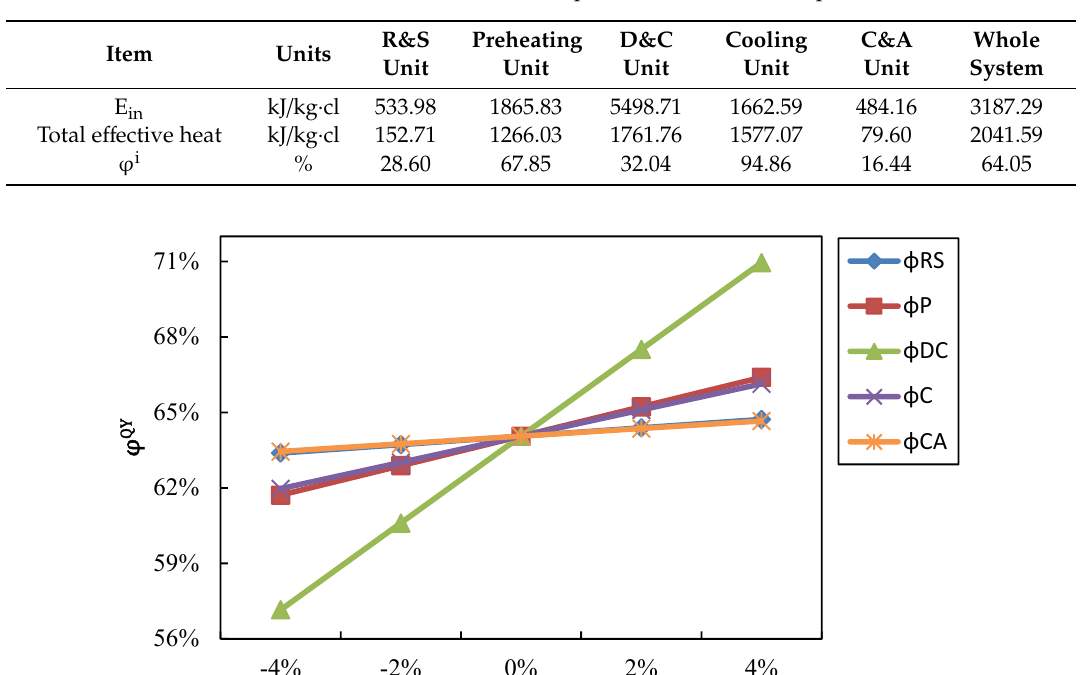
Figure 7. Influence of subunits’ thermal efficiency on φ QY.